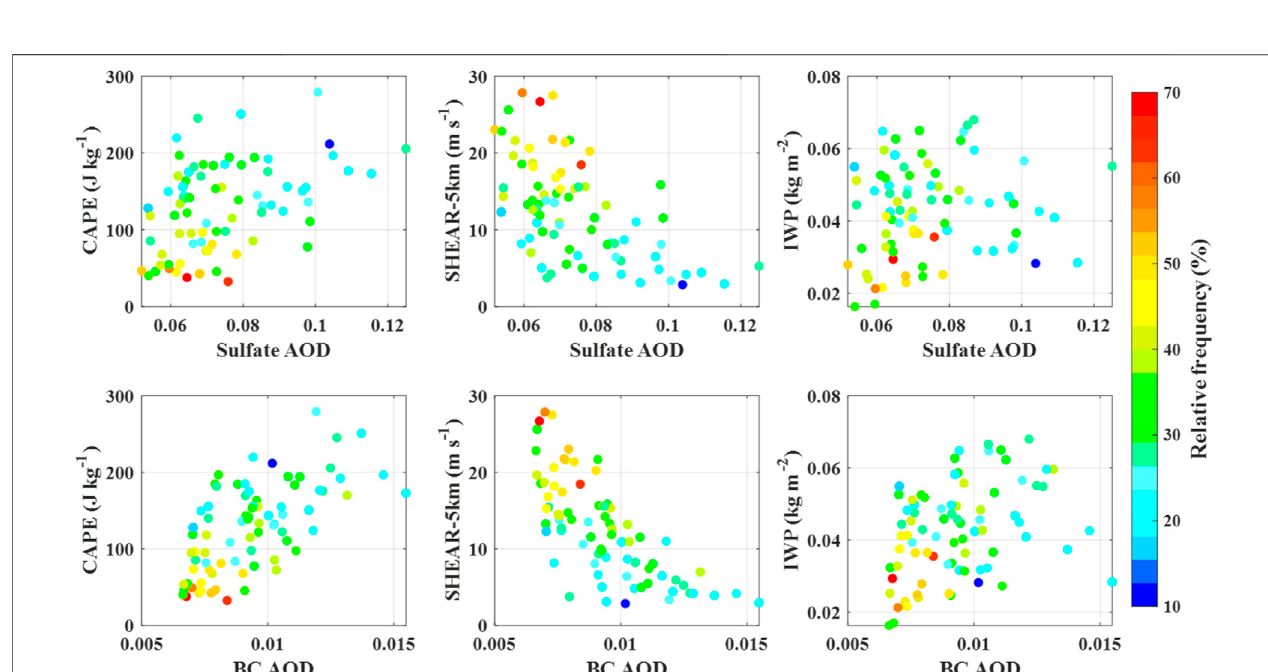
FIGURE 7 | Function of positive CG lightning relative frequency with sulfate AOD, BC AOD, CAPE, SHEAR-5km, and IWP in the plateau region.